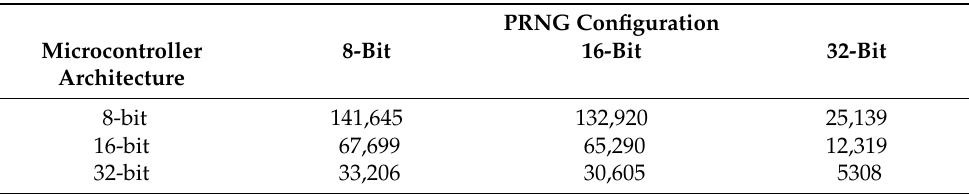
Table 5. Clock cycles consumed by the proposed PRNG when the 8, 16, or 32-bit configurations are used.